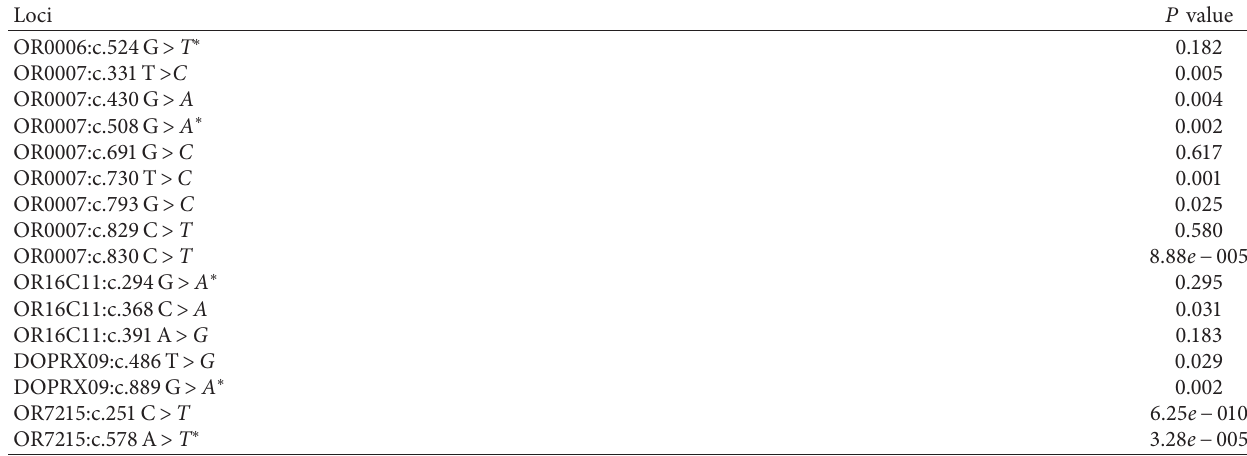
Table 3: Differences of SNP alleles between sniffer dogs and guide dogs.